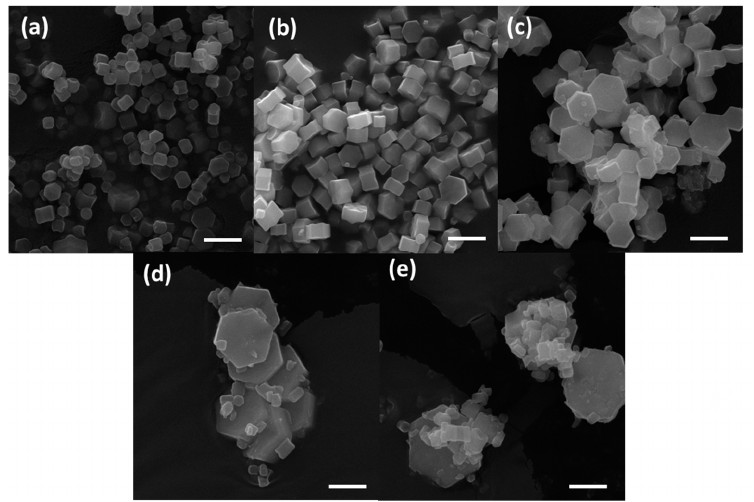
Figure 2. SEM images of the synthesized NaY x F 4 :Yb 0.99 − x Tm 0.01 with Yb 3 + content of ( a ) 29%, ( b ) 49%, ( c ) 69%, ( d ) 99%, and ( e ) NaYb 0.99 F 4 :Tm 0.01 @NaYF 4 . The scale bar represents 1 μ m.